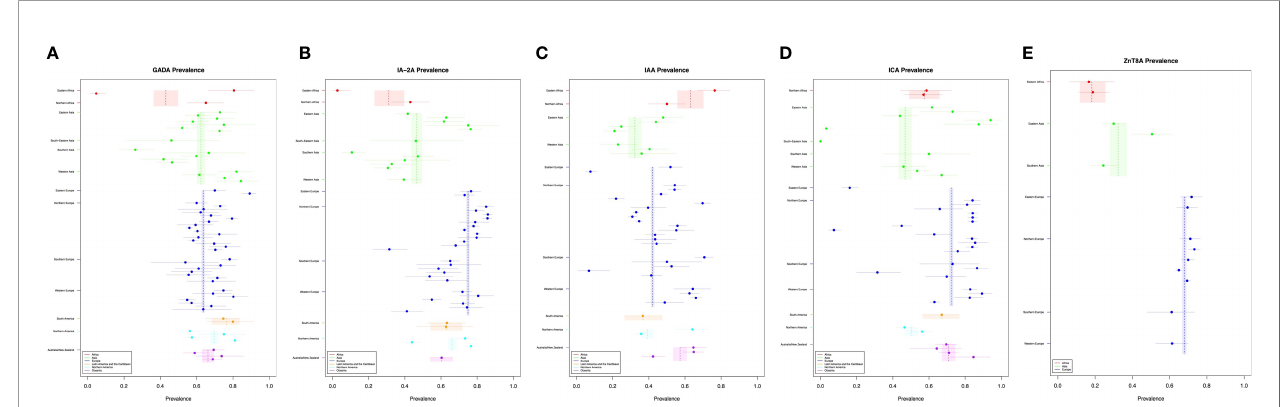
FIGURE 2 | (A – E) New-onset T1DM and islet autoantibody